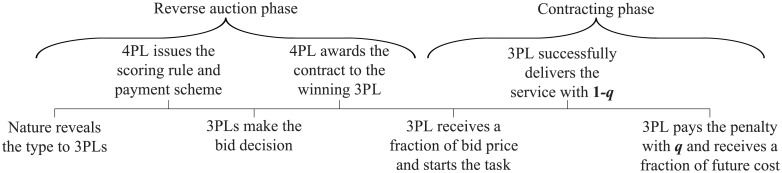
Timing of events.